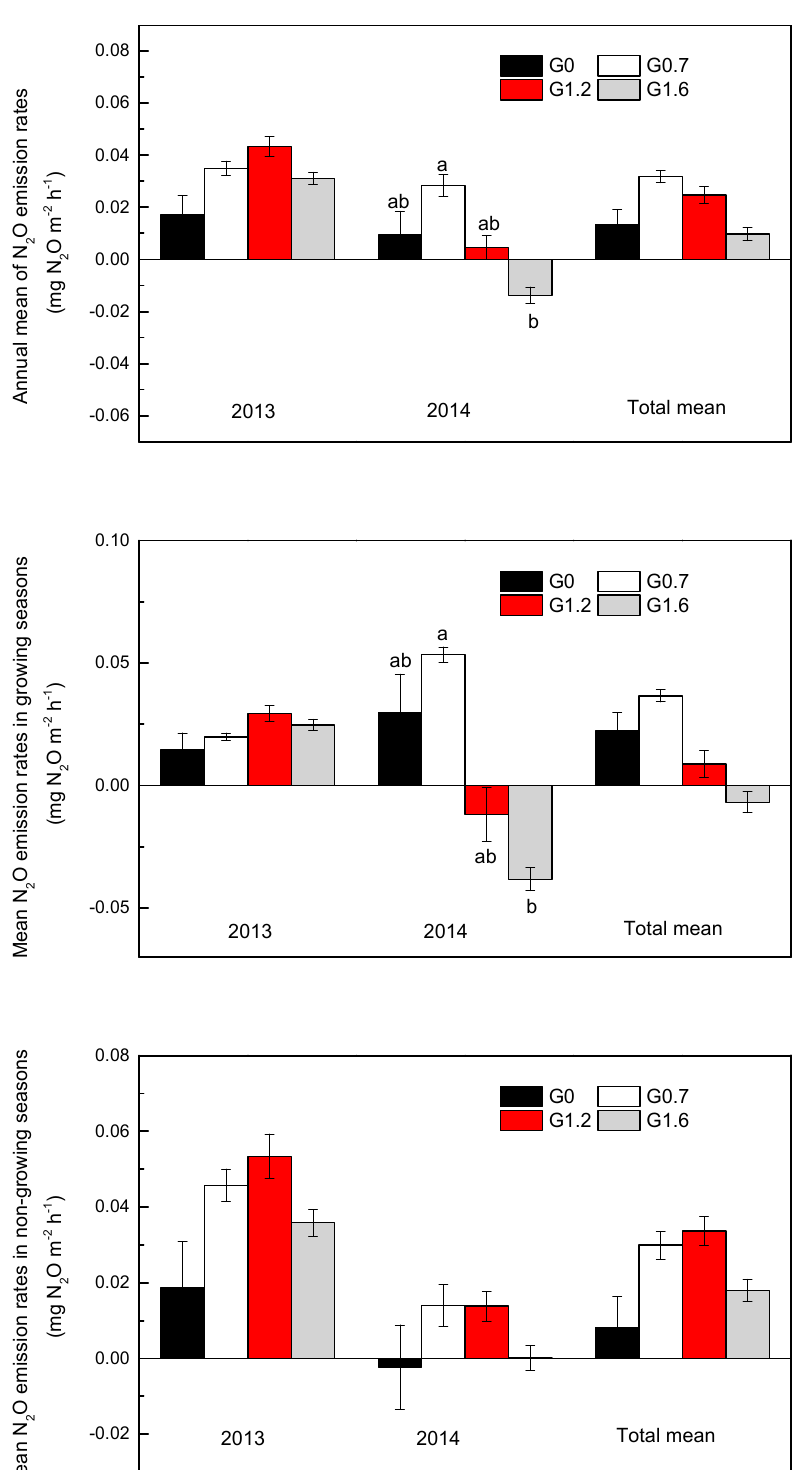
Figure 3. Annual mean of soil N 2 O emission rates under different grazing intensities from 2013 to 2014. Bars represent the means of replicate plots (±SE). Letters a and b mean significant differences ( p < 0.05).